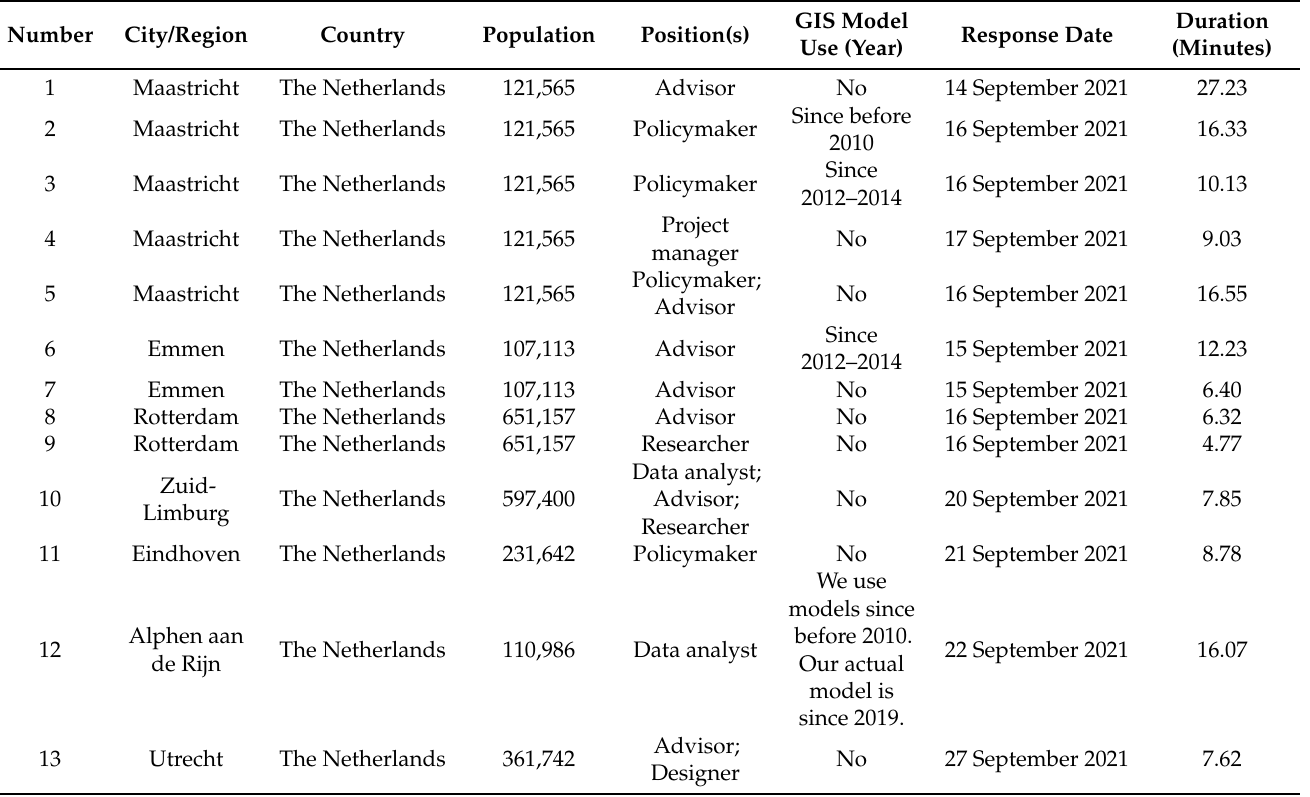
Table A1. Basic information about the responses and